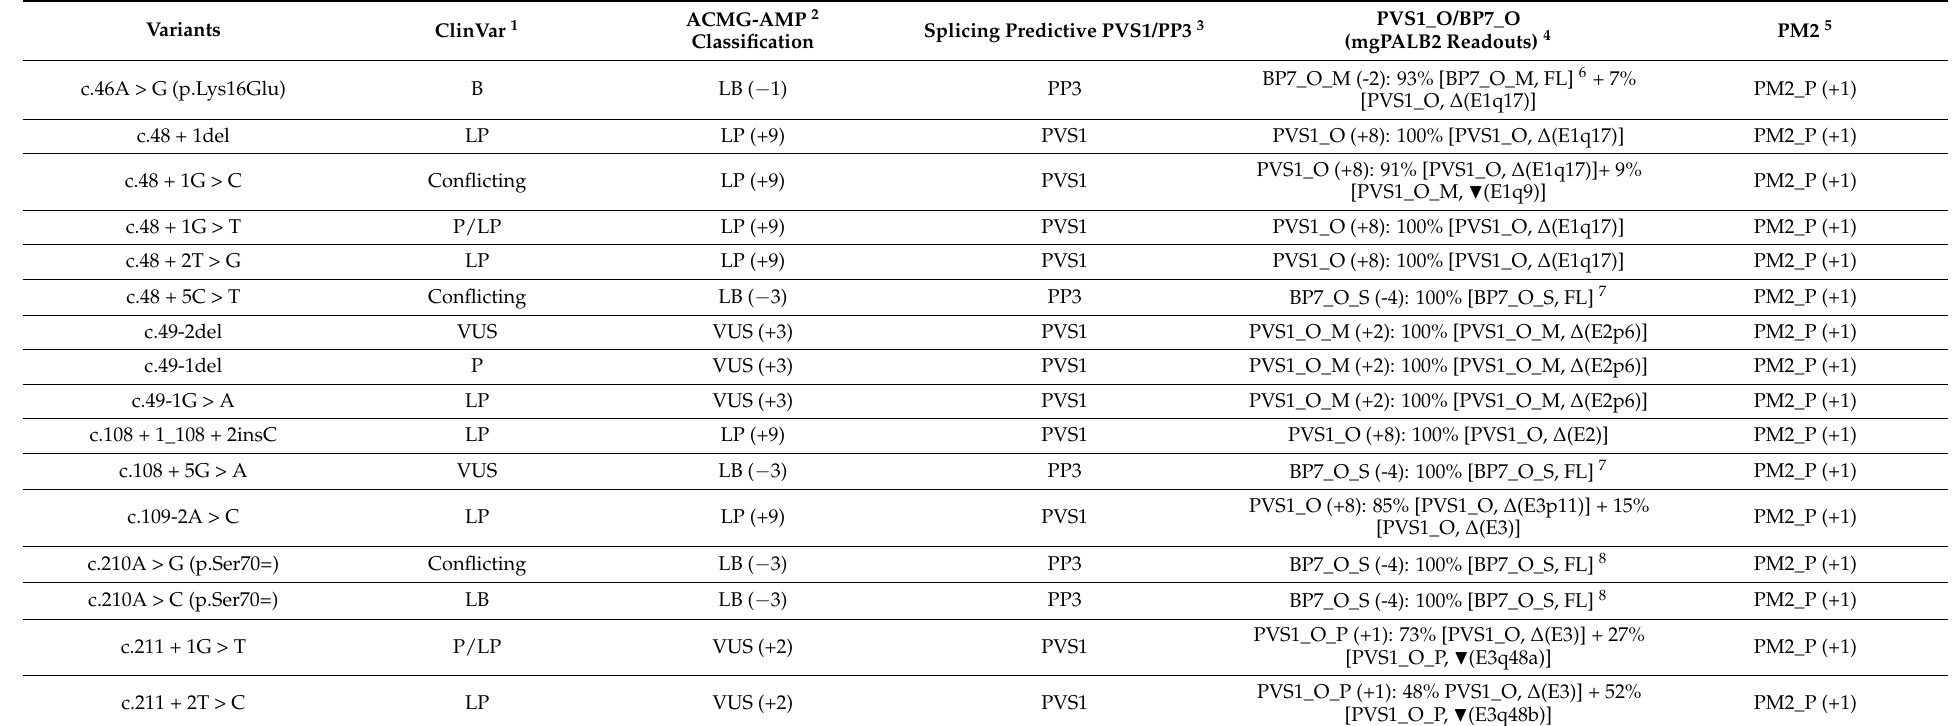
Table 5. ACMG/AMP-based classification of 16 PALB2 variants at exons 1 to